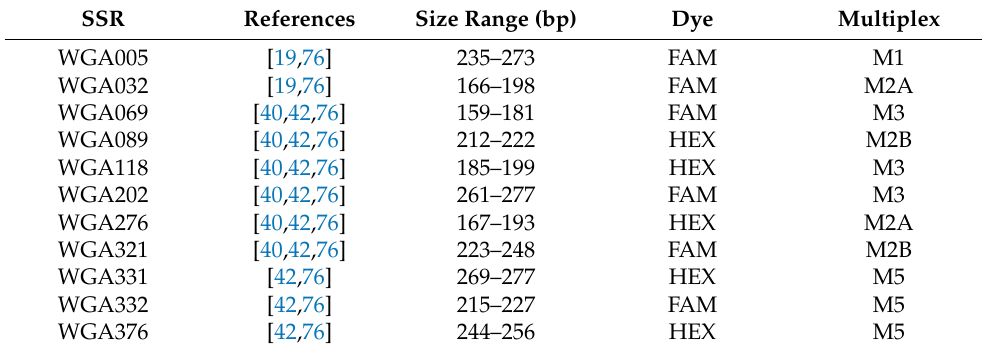
Table 3. Microsatellite loci used to characterize the walnut